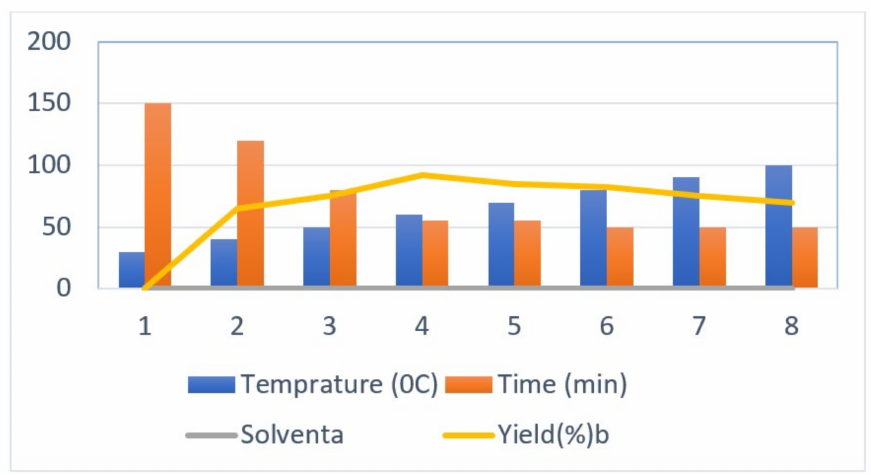
Figure 3. Optimization of temperature for the synthesis of 1,5-benzothiazepine derivatives.